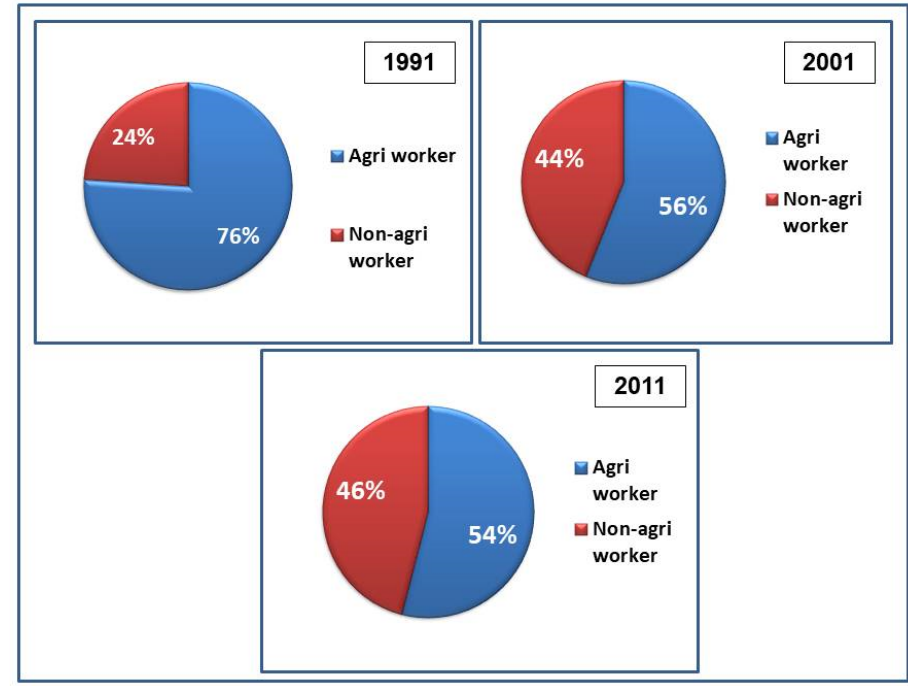
Figure 15. Overall trend of occupation shifting in the study area.